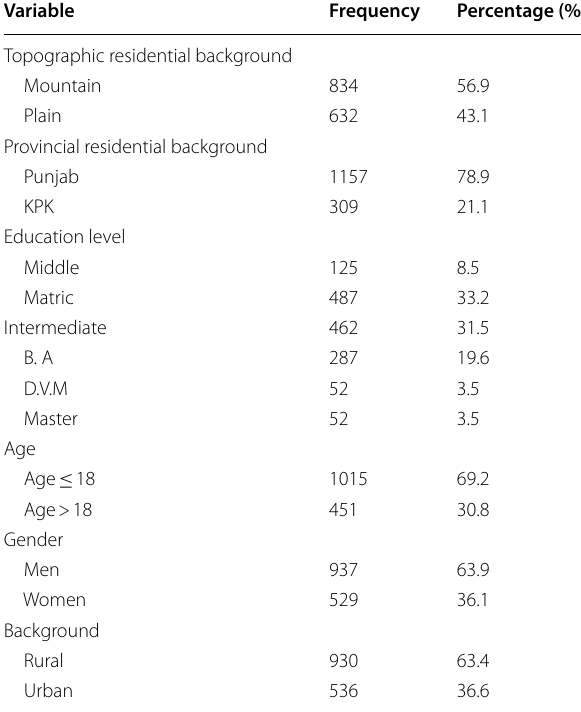
Table 1 Demographic characterisitic of study respondents. A cross-sectional survey on fruit bat-human interaction in Pakistan;